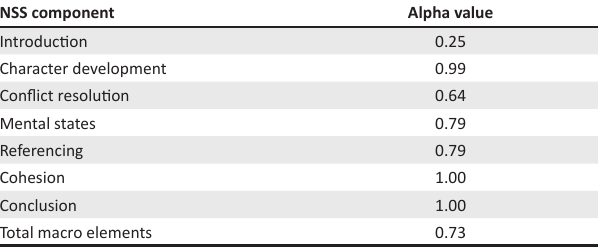
TABLE 2: Krippendorff’s alpha values obtained for NSS scoring